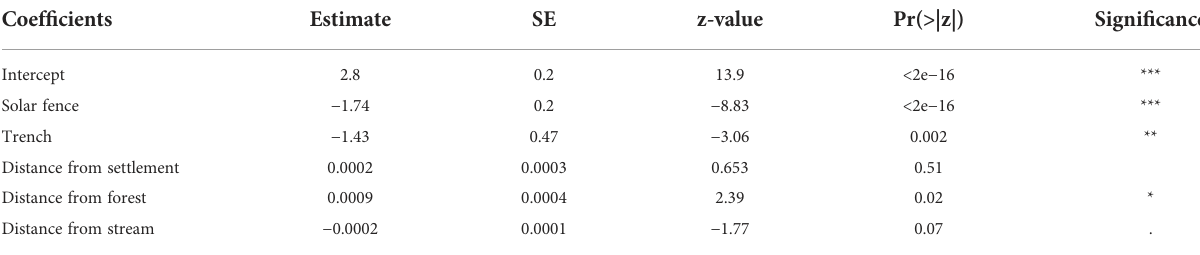
TABLE 4 Estimates of predictor variables towards the elephant encounter rate as per the least AICc-based best fi t model ( “ mod6 ” global